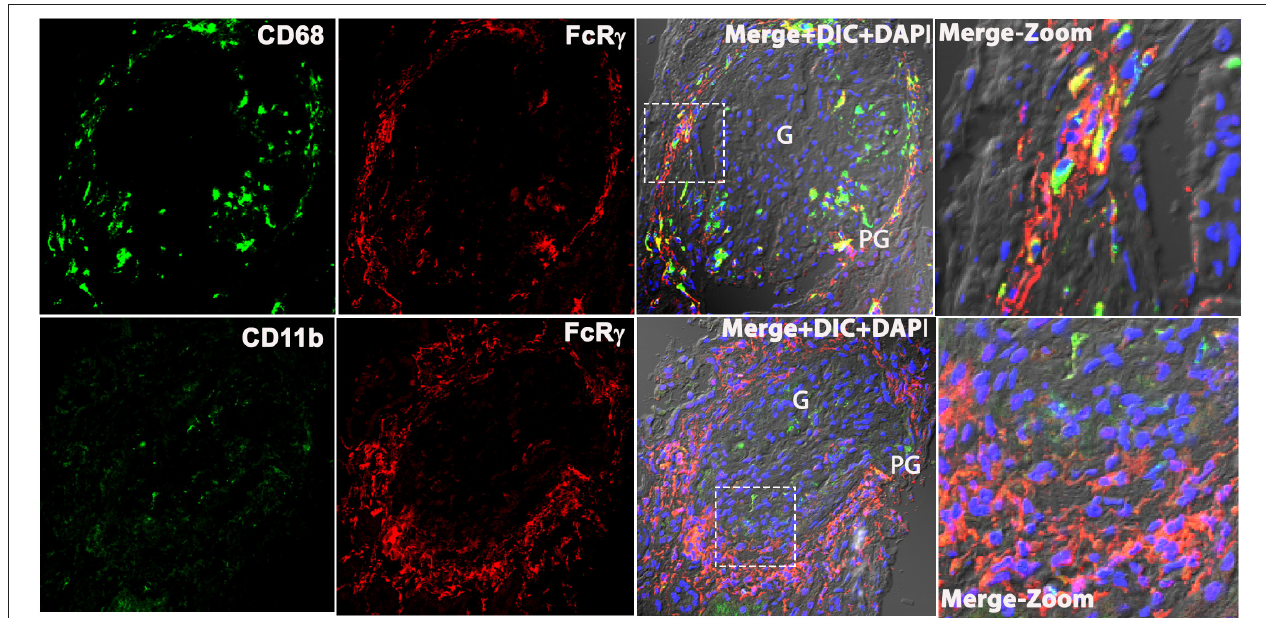
FIGURE 3 | Macrophage markers CD68 and CD11b does not colocalize with FcR γ in the patient’s kidney with LN. Three color confocal IF image that is representative of the 3 human LN kidneys showing no colocalization of CD68 (green) with FcR γ (red) (top row) in the PG region in the kidney and CD11b (green) with FcR γ (red) (bottom row). The third column shows merged images of the first 2 columns plus DIC and DAPI staining of nuclei (blue). The fourth column shows the zoomed image of the third column highlighted using a dotted